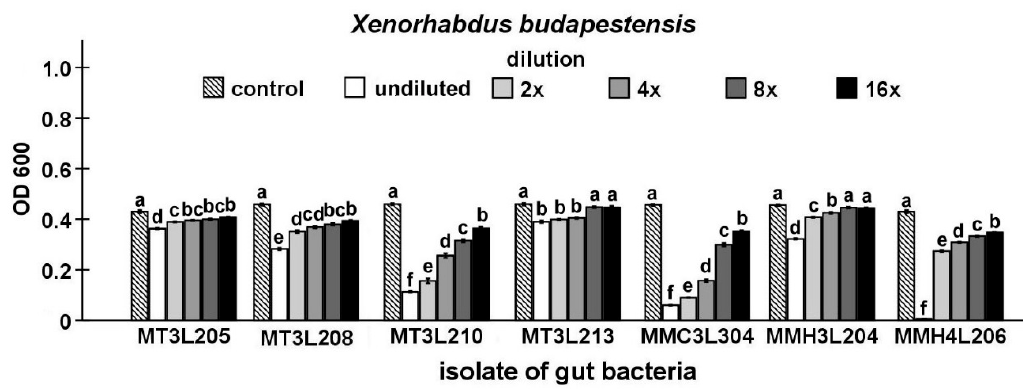
Figure 5. Antagonistic activities of different dilutions of culture supernatants from selected M. melolontha midgut isolates against X. budapestensis shown by MID tests. The same letters mean no significant differences between the activities of supernatants from the same midgut isolate.